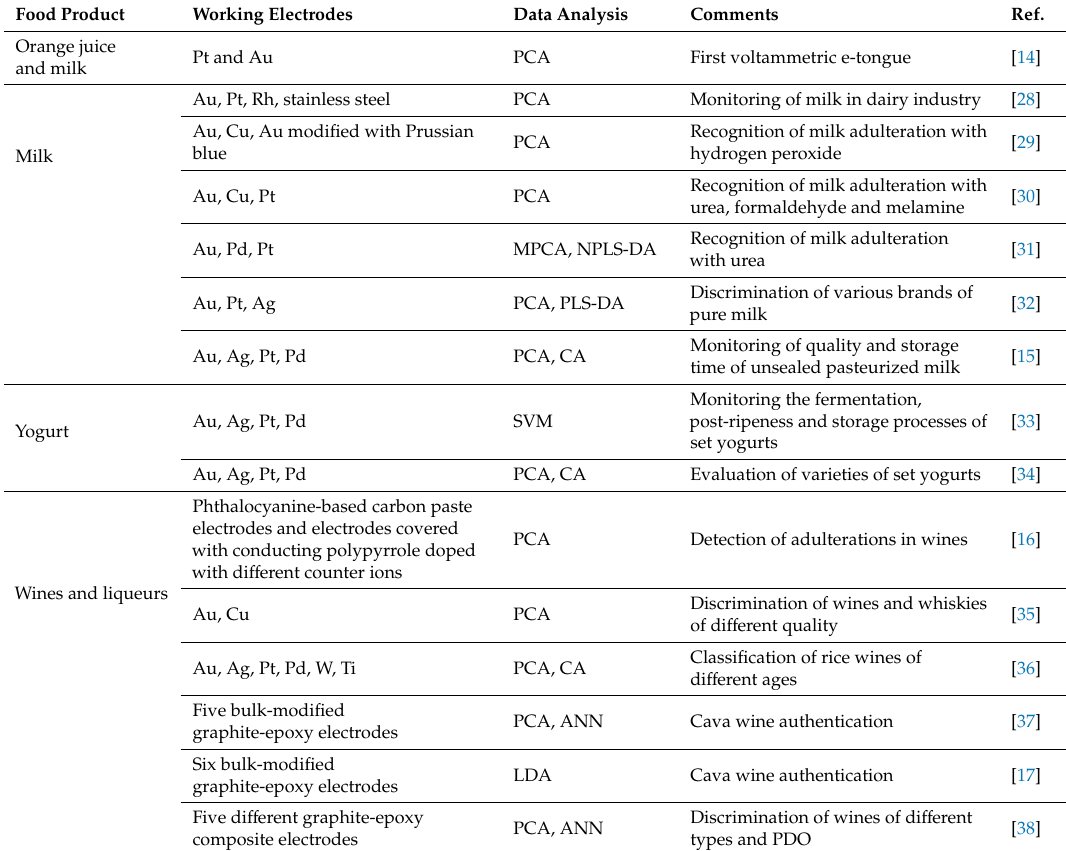
Table 1. Selected works dealing about the characterization, classification and authentication of food products with voltammetric electronic